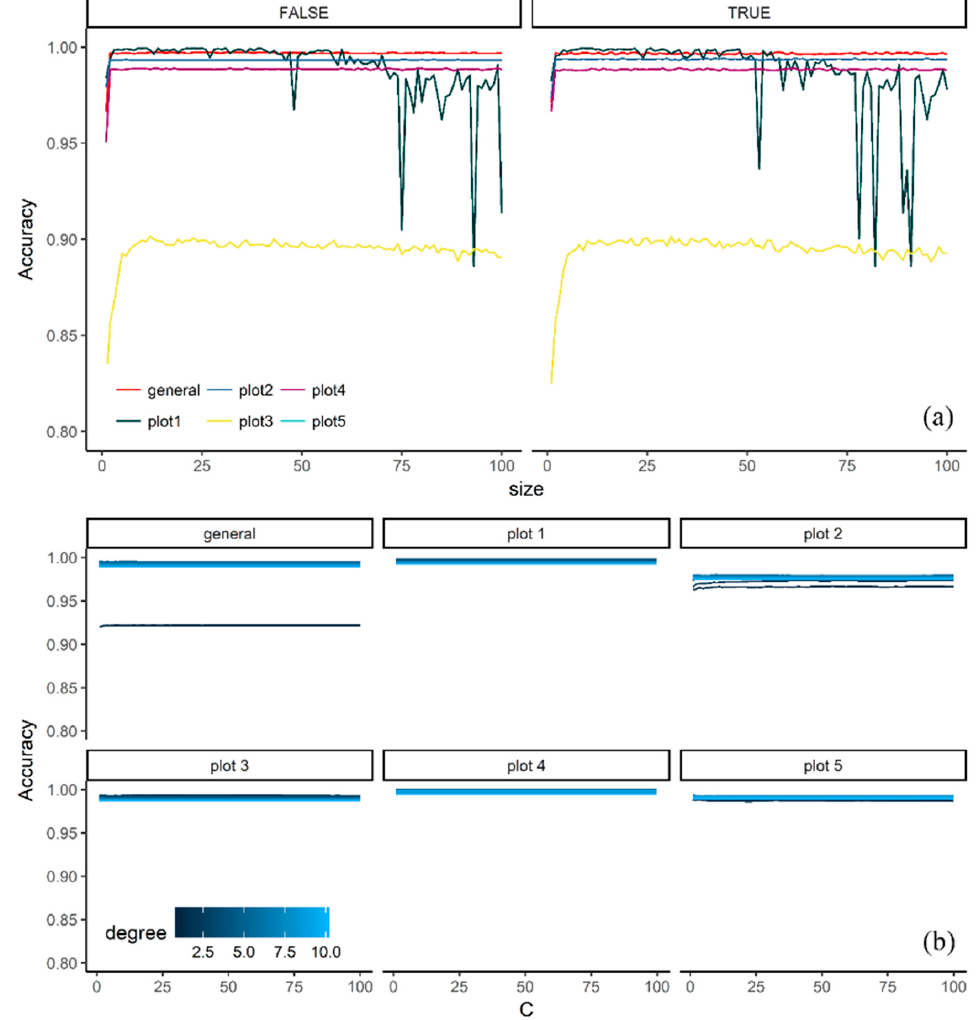
Figure 4. Accuracy of the validation samples of the two classification algorithms using the Bootstrap 632. ( a ) Averaged neural network with bagging (TRUE, FALSE)’, ( b ) support vector machine with polynomial kernel.